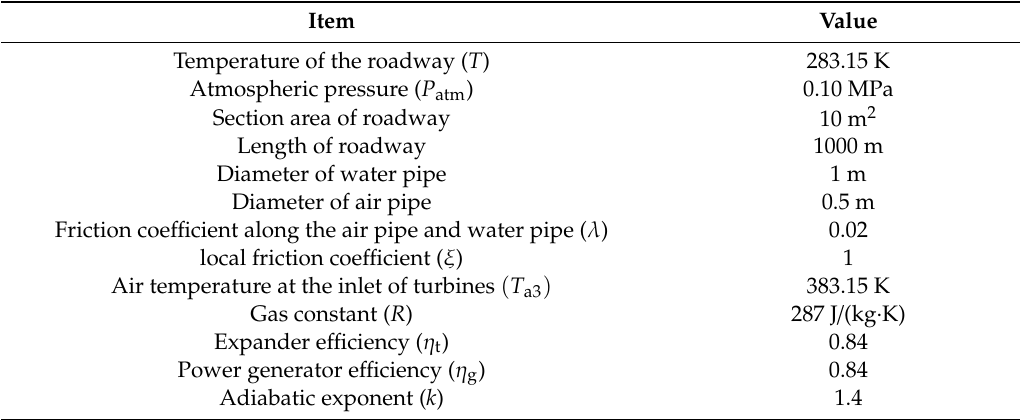
Table 1. Values of the system parameters.